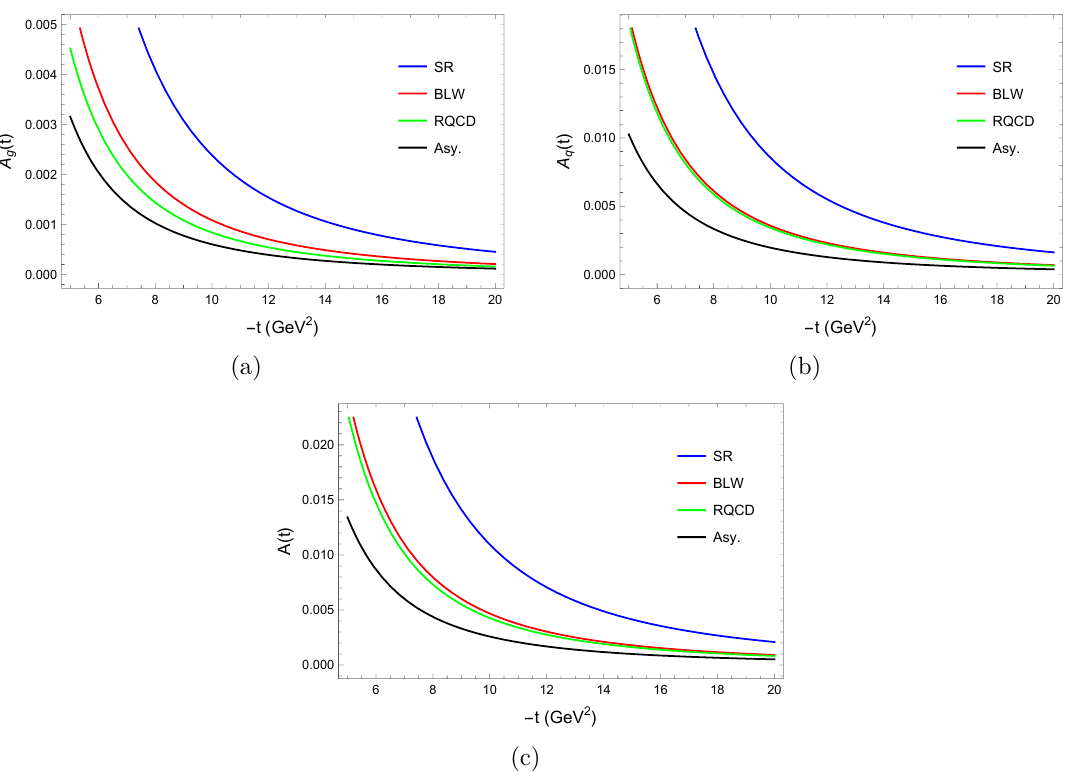
Figure 2. A q,g ( t ) and A ( t ) with different estimates or models of nucleon DAs: QCD sum rule(SR) [81, 98], Lattice simulations conducted by RQCD collaboration [104], Braun-Lenz- Wittman(BLW) model [98], the asymptotic(Asy.) model.